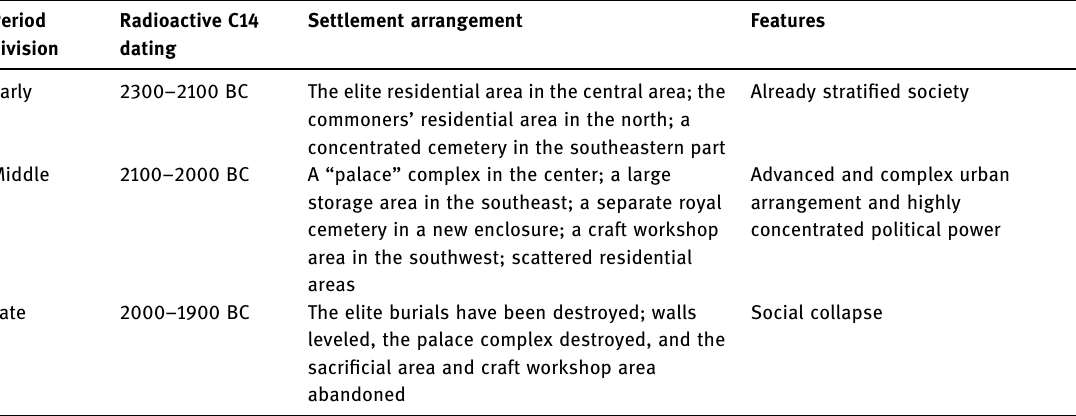
Table 1: The periodization and settlement arrangement of the of Taosi site ( based on He, 2018